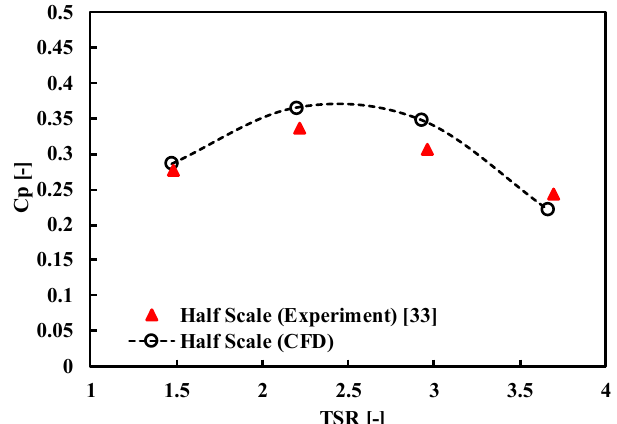
Figure 9. Comparison between experimental and numerical results (optimum inlet velocity is adopted at 2.5 m/s for computational study).